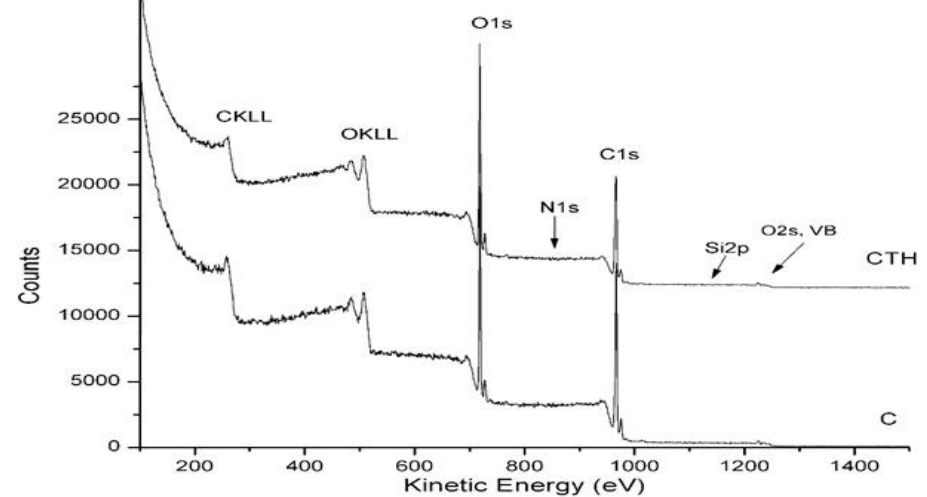
Figure 9. Wide spectrum of thermally modified (CTH, top ) and unmodified cedar wood samples (C, bottom ).